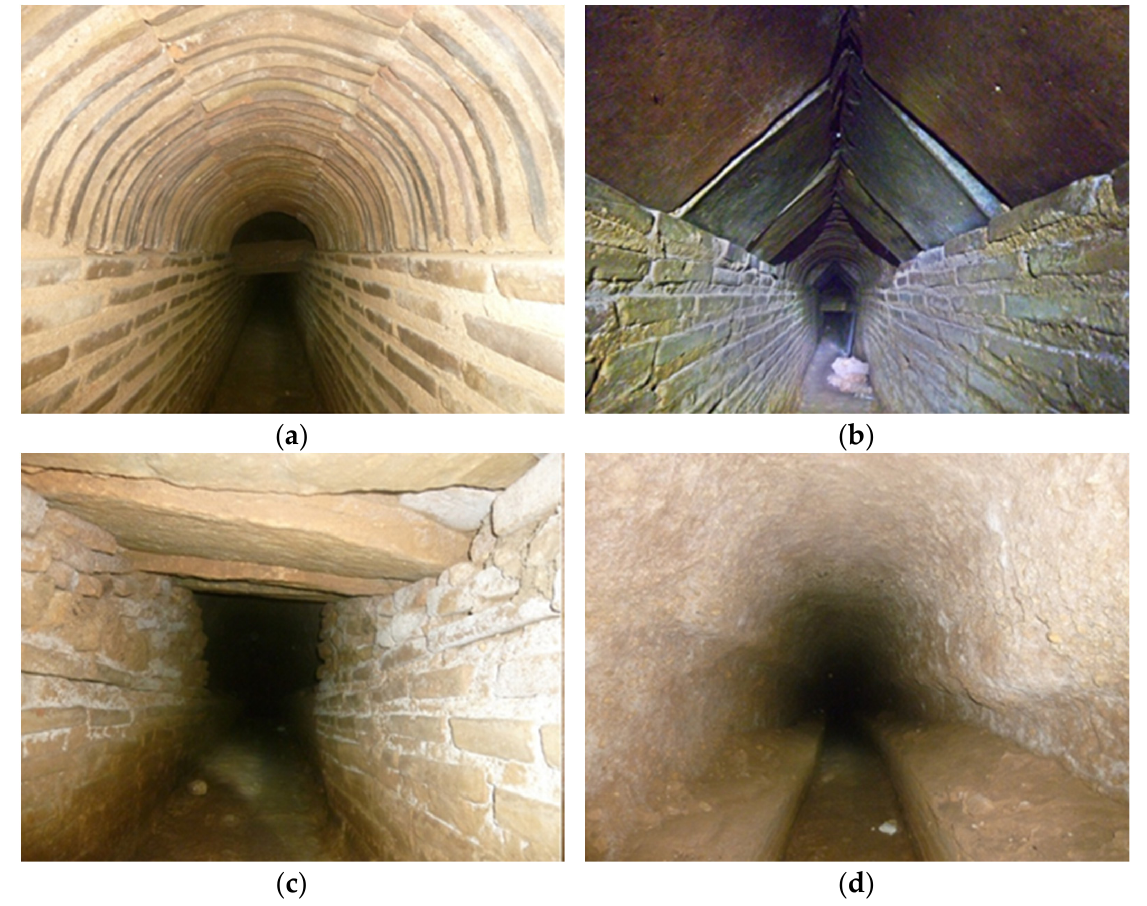
Figure 16. (a – d) Different views of the tunnel of the Hadrianic aqueduct. Figure 16. ( a – d ) Different views of the tunnel of the Hadrianic aqueduct.